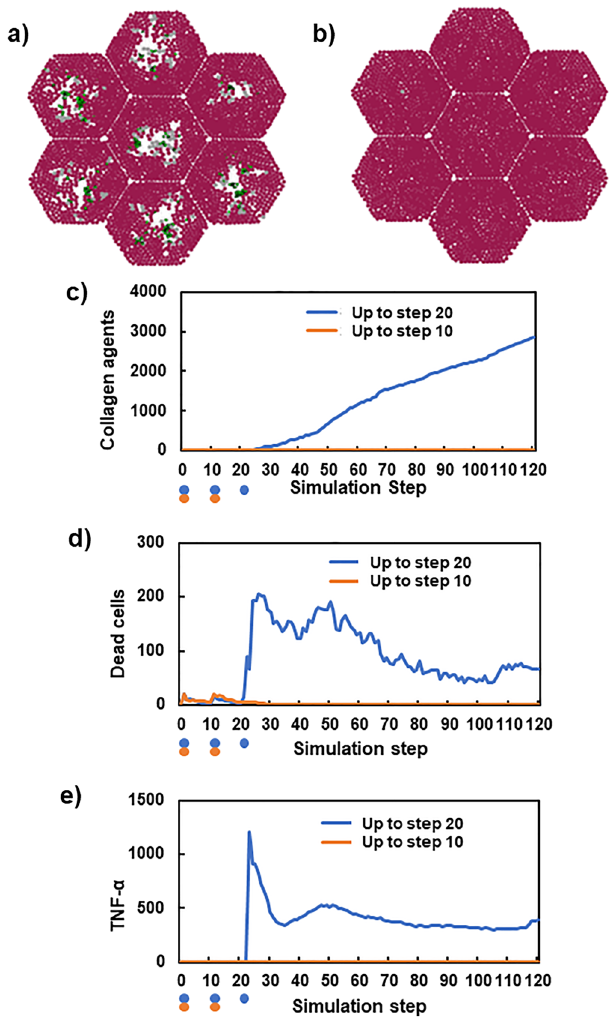
Figure 5. Comparison of the processes of fibrosis between two CCl 4 injection conditions. Panels ( a ) and ( b ) show simulated liver lobules after 100 steps. CCl 4 was injected thrice ( a ) and twice ( b ). Hepatocytes (brown), dead cells (grey), and collagens secreted from myofibroblasts and portal fibroblasts (blue and green). The initial conditions before simulation are depicted in Fig. S2. Time courses of the number of collagen agents ( c ), dead cells ( d ), and TNF-α ( e ). Orange and blue circles indicate the timing of CCl 4